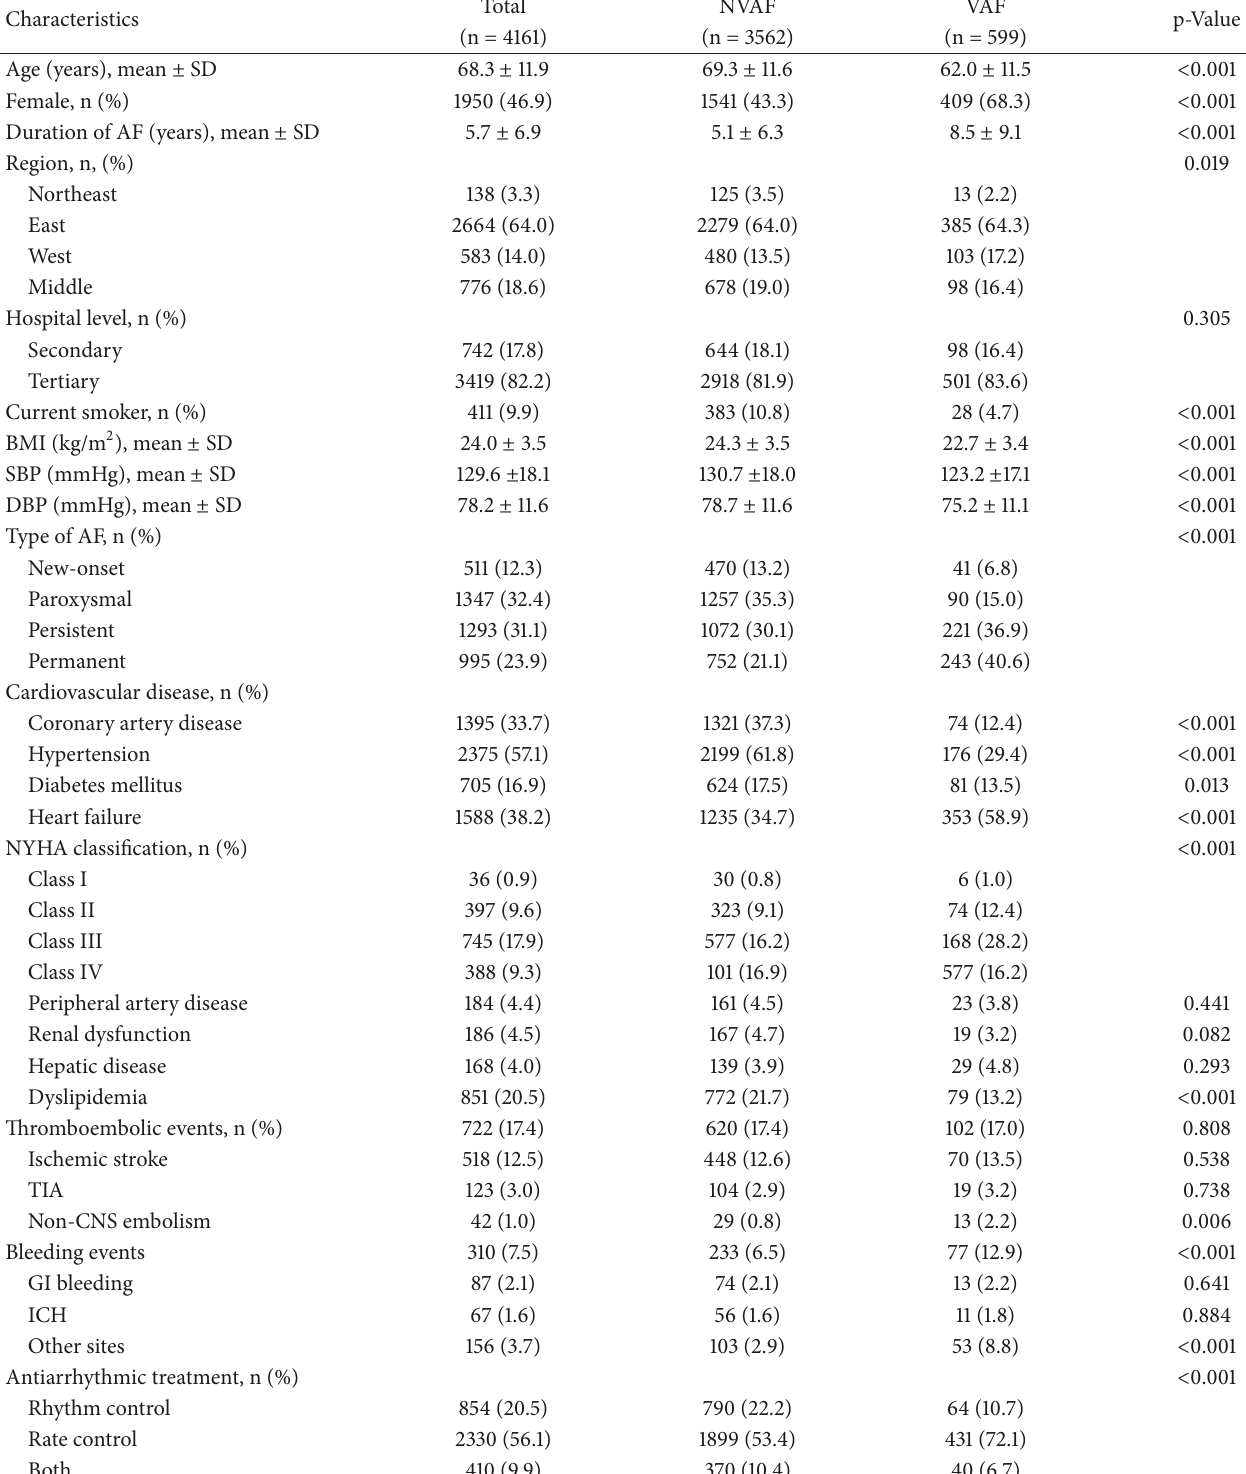
Table 1: Patient